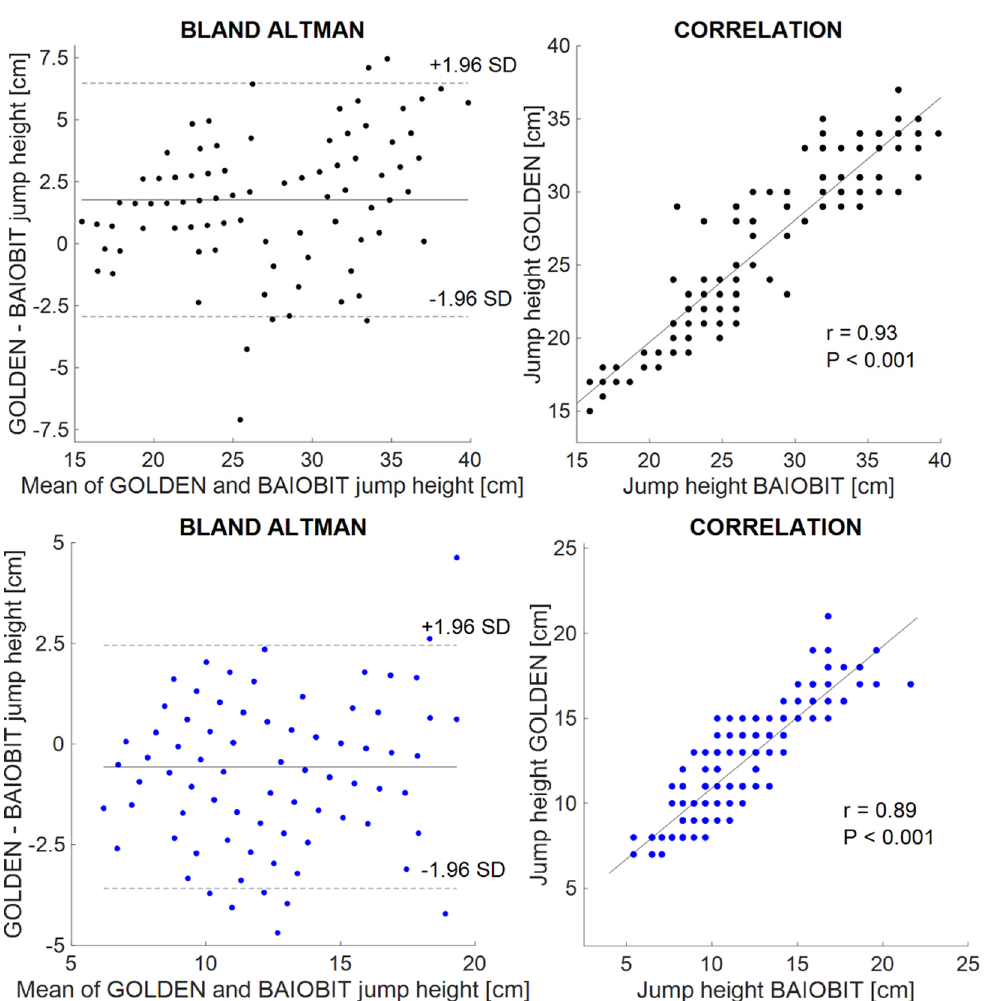
Figure 3. ( Top ) Double-leg CMJs on the left of the Bland–Altman plot comparing the force platform data (gold standard) vs. the Baiobit on the right of the correlation between the force plate and the Baiobit. ( Bottom ) Single-leg CMJs on the left of the Bland–Altman plot comparing the force platform data (gold standard) vs. the Baiobit on the right of the correlation between the force plate and the Baiobit.